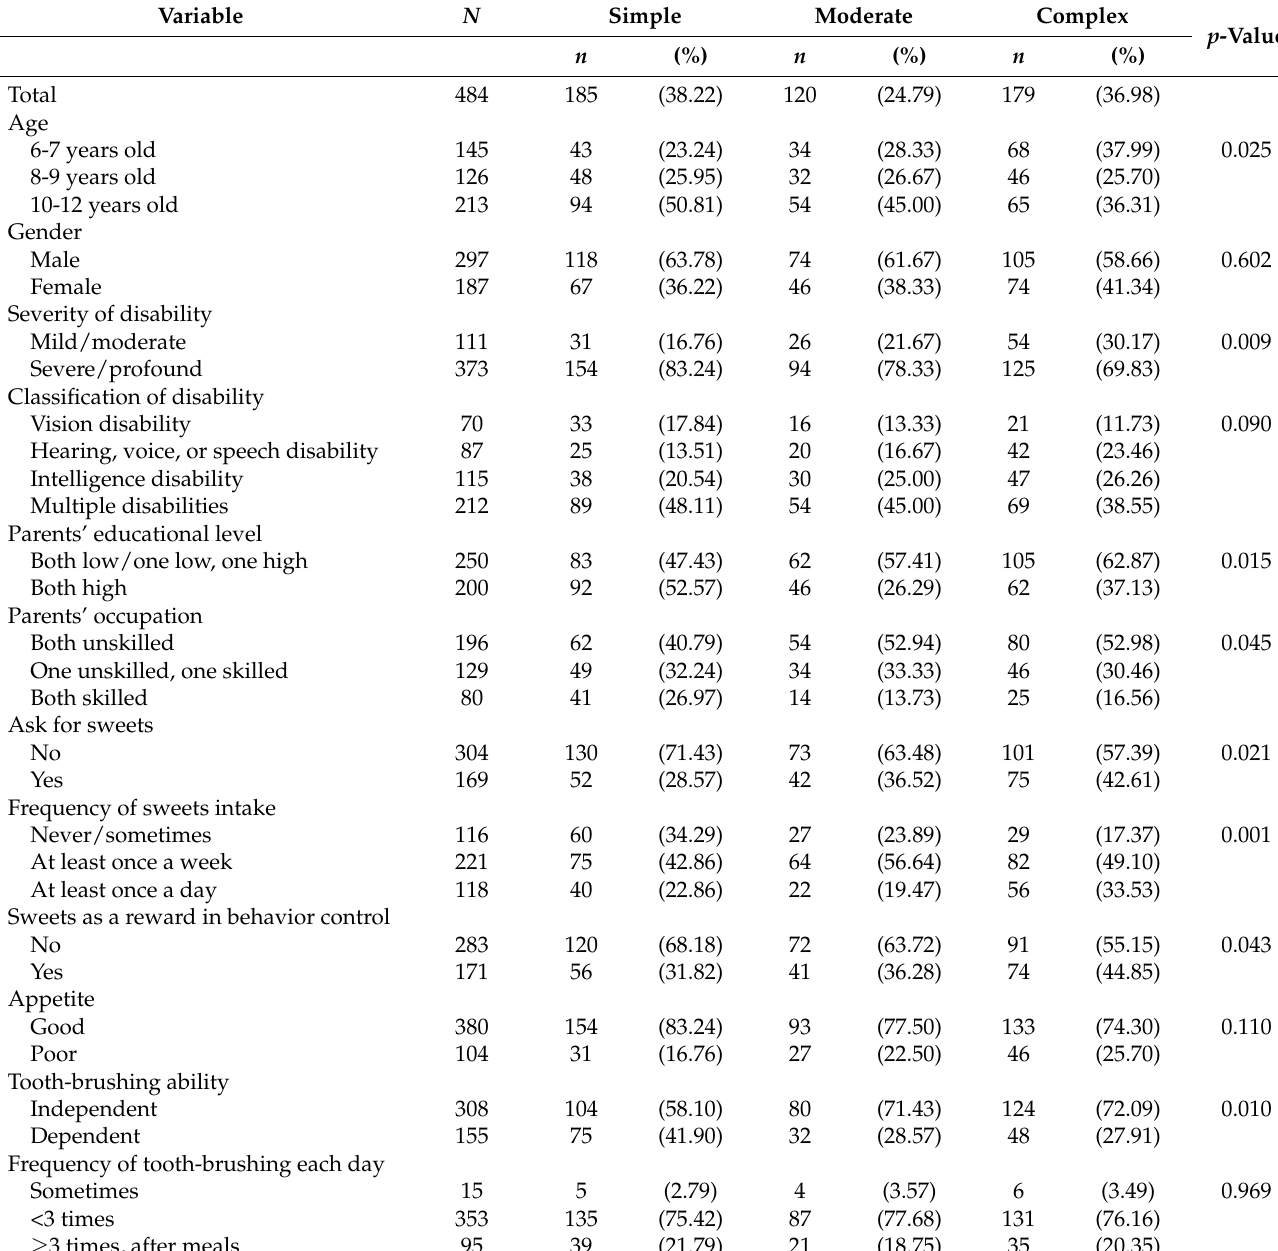
Table 2. Dental treatment modalities by demographics and dietary and tooth-brushing habits among children with